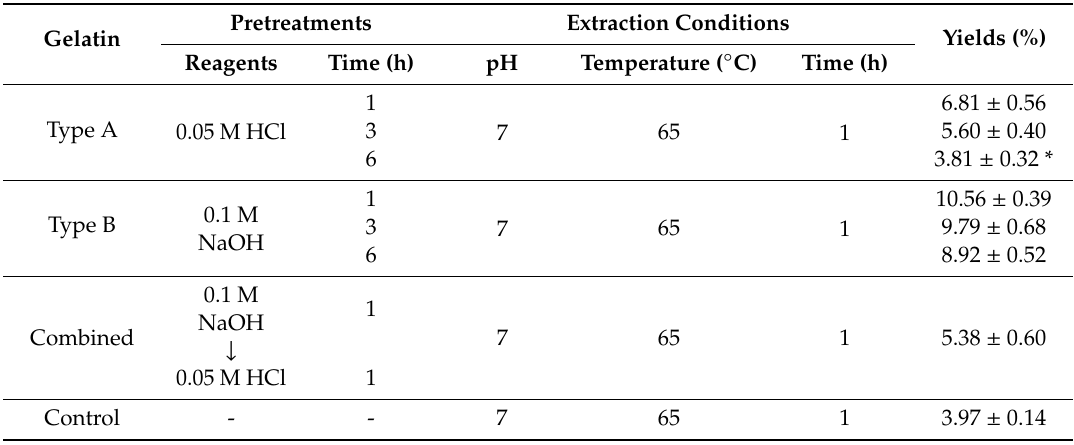
Table 1. Yields (%, dry weight gelatin / wet weight sample) of gelatins extracted from the head skin of Kalamtra sturgeon after di ff erent pretreatment